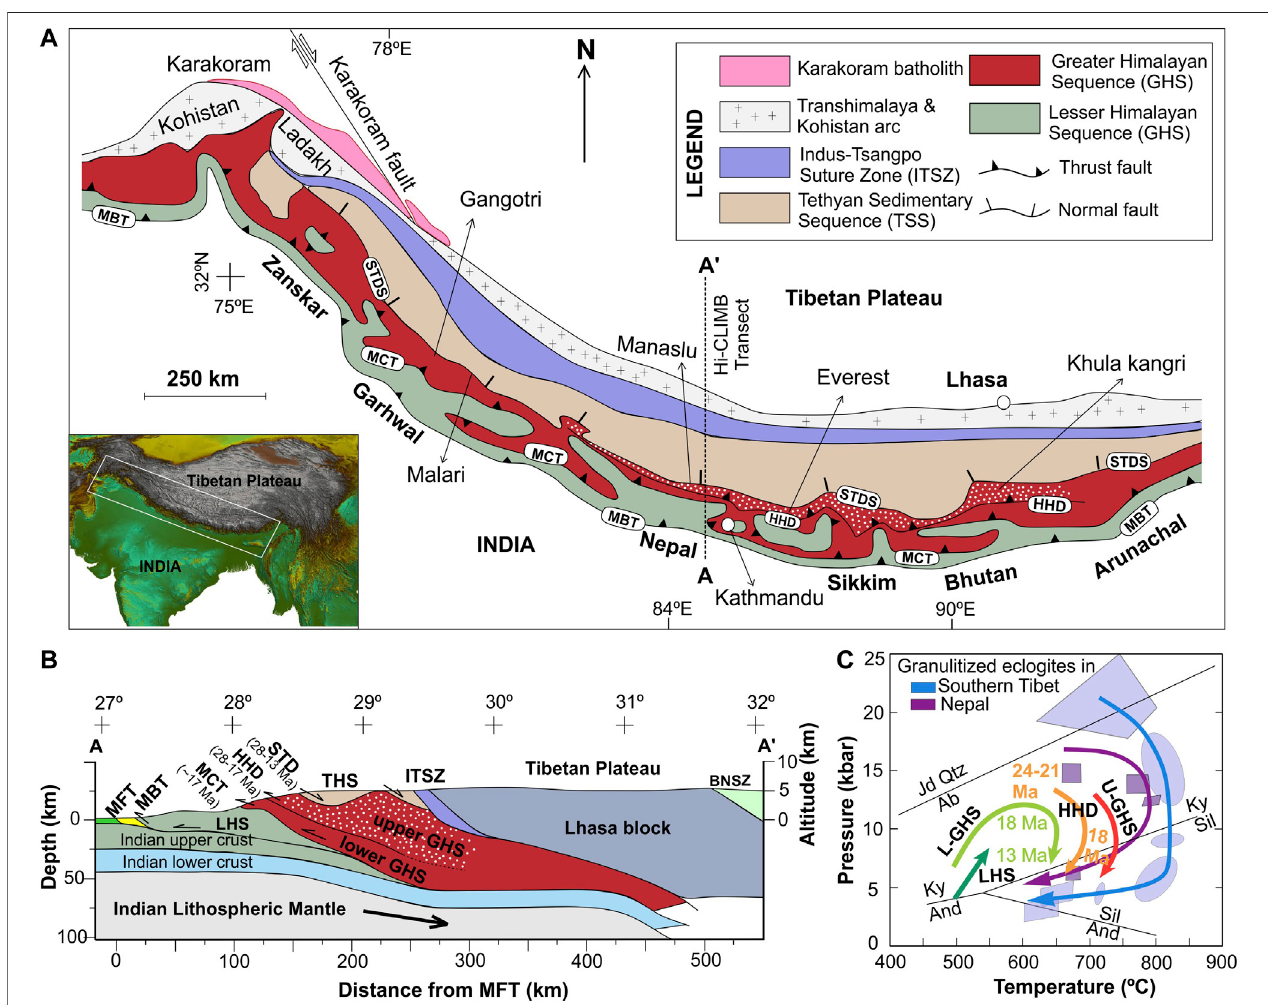
FIGURE 1 | (A) A geological map of the Himalaya showing the major tectonic units and their boundaries (after Carosi et al., 2018; Wang et al., 2016). MBT: main boundary thrust; MCT: main central thrust; STDS: south tibetan detachment system. (B) Lithospheric-scale cross-section of the Himalaya-Tibet system at 85 ° Eused to show depth-wise dispositions of the tectonic units (after Godin and Harris, 2014; Carosi et al., 2018). (C) P - T-t path of exhumed high-pressure rocks in the GHS (Kohn, 2014; Iccarino et al., 2017; Waters, 2019).